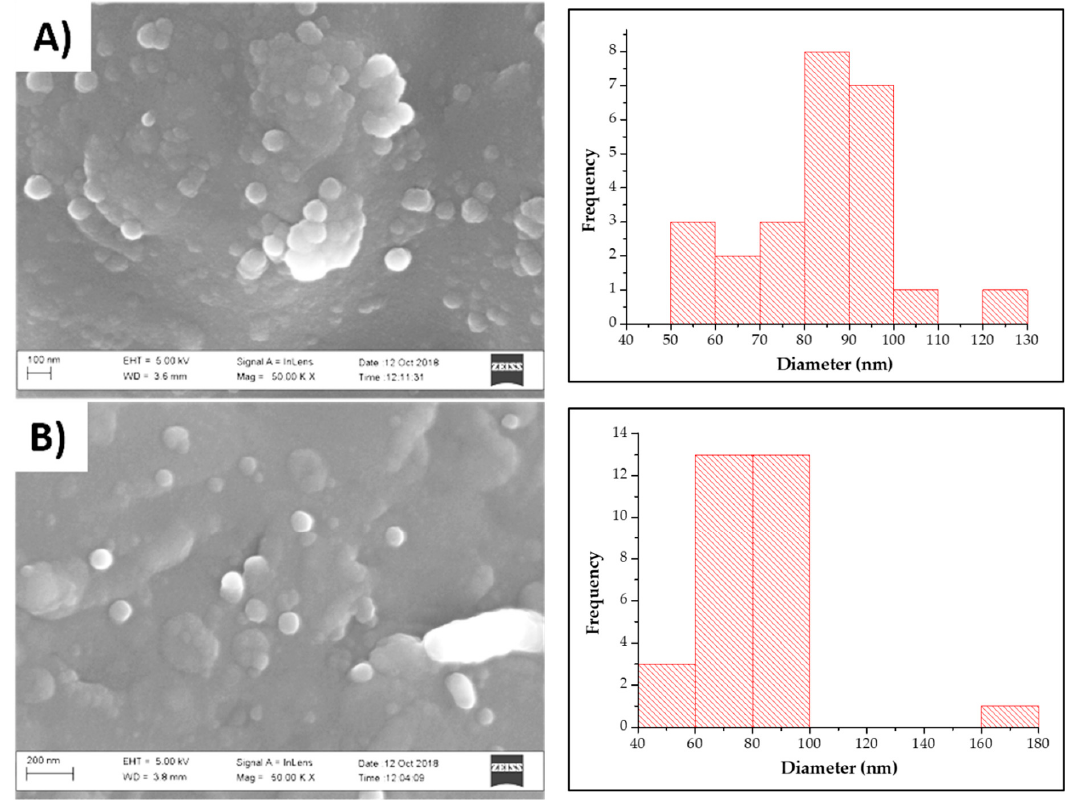
Figure 3. SEM images of Variabilin Loaded Stearic Acid Solid Lipid Nanoparticles (Var-SLNs) ( A ) and the blank SLNs ( B ) together with their corresponding diameter histograms. Table 1. Dynamic Light Scattering (DLS) hydrodynamic radii and Zeta potential measurements for the SLNs.